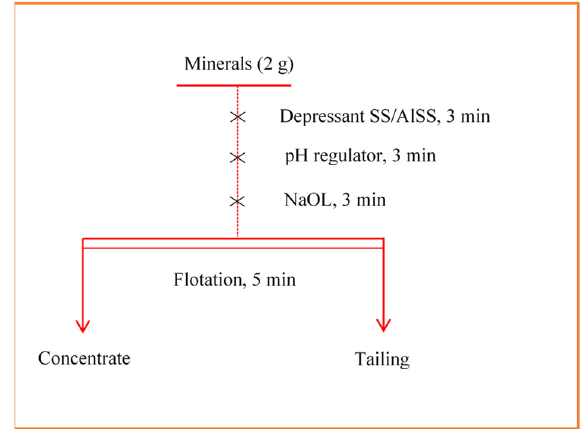
Figure 2. Flowsheet of micro-flotation experiment.